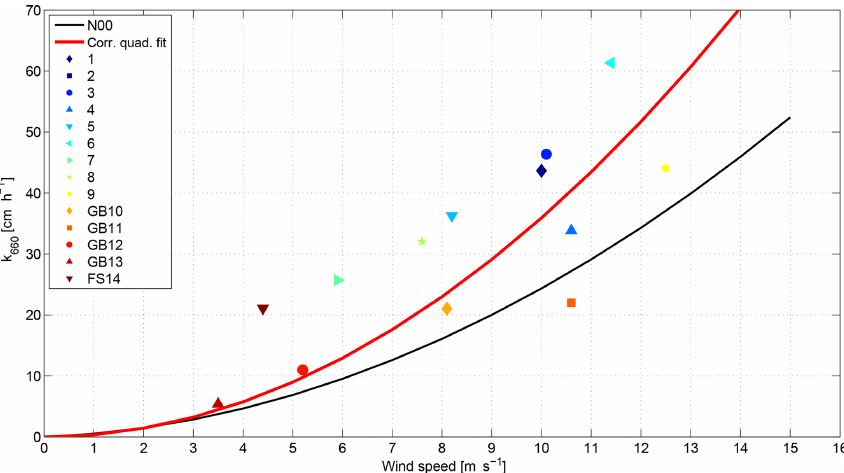
Figure 5. Adjusted individual measurements, comprising the N00 parameterization, resulting from the algorithm described in Sect. 3. The difference between u alt and the original u 10 was added to k using the linear parameterization ZA18, which accounts for the suppression of k o due to wind–wave interaction. The solid black line is the original N00 parametrization. The red line is a new quadratic fit to the adjusted datapoints k = 0 . 359 · u 2